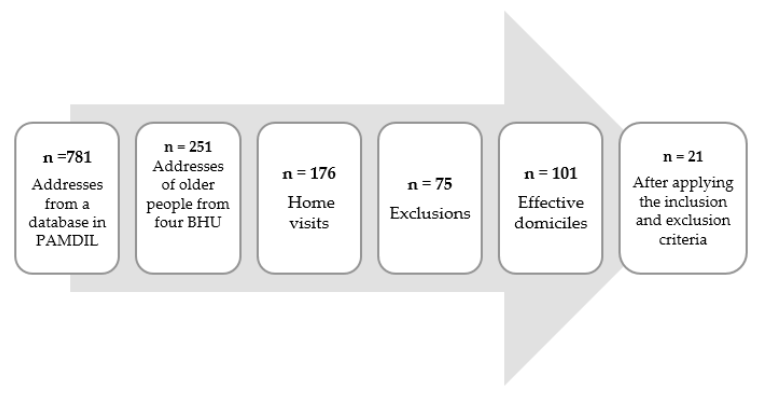
Figure 1. Sampling procedure of